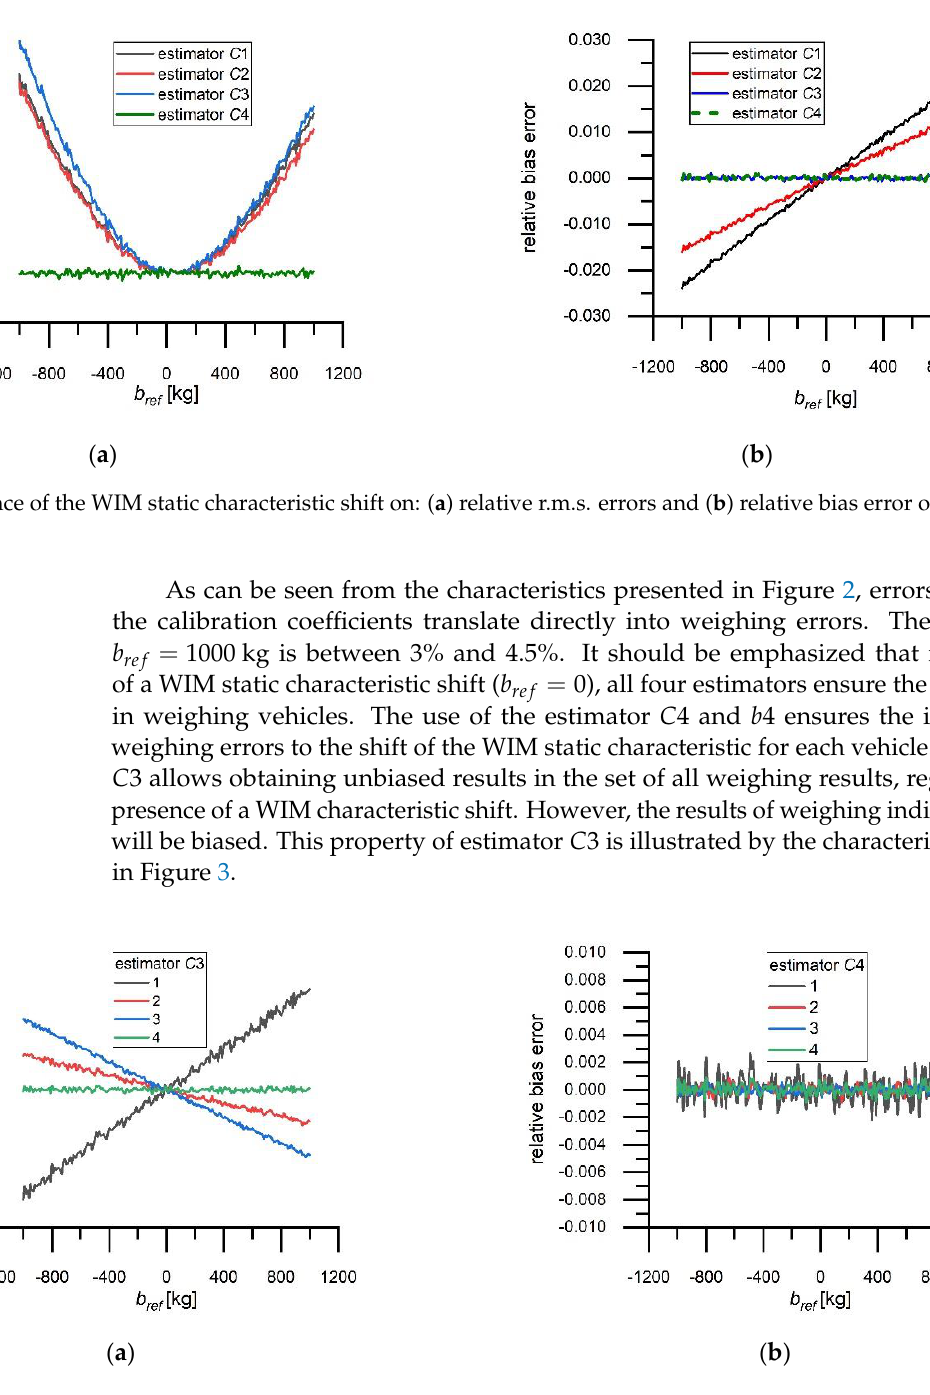
Figure 3. Bias of results of weighing on the WIM station calibrated according to the algorithm: ( a ) 𝐶3 , ( b ) 𝐶4 . (1 – 3) bias errors of weighing of three exemplary test vehicles and (4) sum of these bias errors, 𝐶 𝑟𝑒𝑓 = 1 .